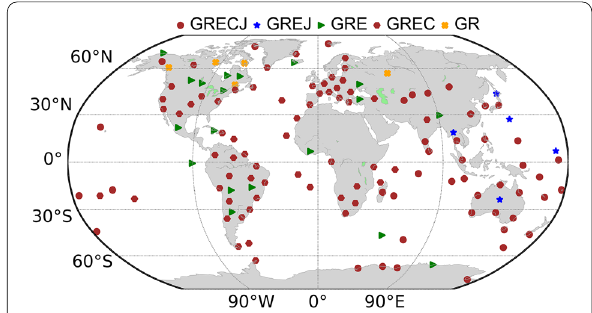
Fig. 2 Distribution of global stations used for ASB calibrations of individual AC clock products. These stations are also used for PPP validation with combined orbit and clock solutions. The abbreviations ‘G’, ‘R’, ‘C’, ‘E’ and ‘J’ indicate GPS, GLONASS, Galileo, BDS and QZSS, respectively